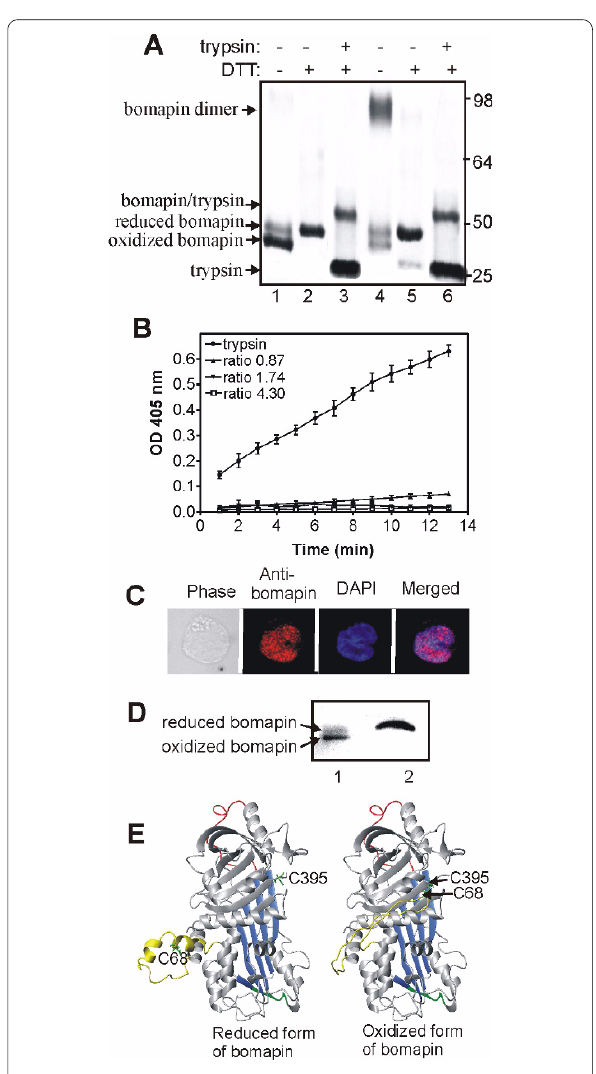
Figure 1 Conformation of the recombinant and naturally ex- pressed bomapin is redox-dependent . (A) Purified recombinant bo- mapin analyzed by SDS-PAGE followed by Coomassie blue staining: lanes 1 and 4, non-reduced bomapin eluted from ion-exchange col- umn in peak 1 and peak 2 (respectively); lanes 2 and 5, DTT-reduced bomapin from peak 1 and peak 2 (respectively); lanes 3 and 6, non-re- duced bomapin from peak 1 and peak 2 (respectively) incubated with a 4-fold molar excess of trypsin and then analyzed under reducing con- ditions. (B) Indirect chromogenic assay to detect inhibitory activity of bomapin. Trypsin alone or trypsin pre-incubated with different amounts of bomapin (at bomapin/trypsin molar ratios as indicated) was mixed with S-2288 chromogenic substrate, and residual trypsin activity was measured at 405 nm in 1 min time intervals. (C) Immuno- localization of naturally expressed bomapin in THP1 cells. The cells were stained with rabbit anti-bomapin antibodies followed by Alexa- Fluor 568-labeled secondary antibody; DNA was stained with DAPI. (D) Bomapin was immunoprecipitated from HL60 cell extract and ana- lyzed by SDS-PAGE followed by western blot: lane 1, non-reduced bo- mapin; lane 2, DTT-reduced bomapin. (E) In silico homology models of bomapin in its reduced and oxidized forms. The central β-sheet A is shown in blue, the reactive centre loop in red, the CD-loop in yellow, and the two cysteine residues in